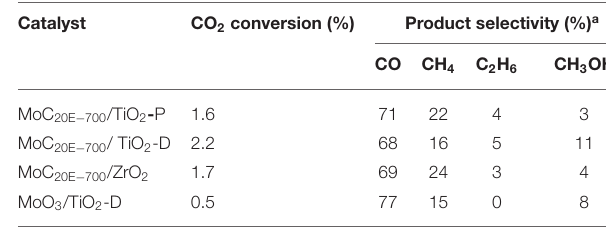
TABLE 3 | Effect of the support nature on the catalytic